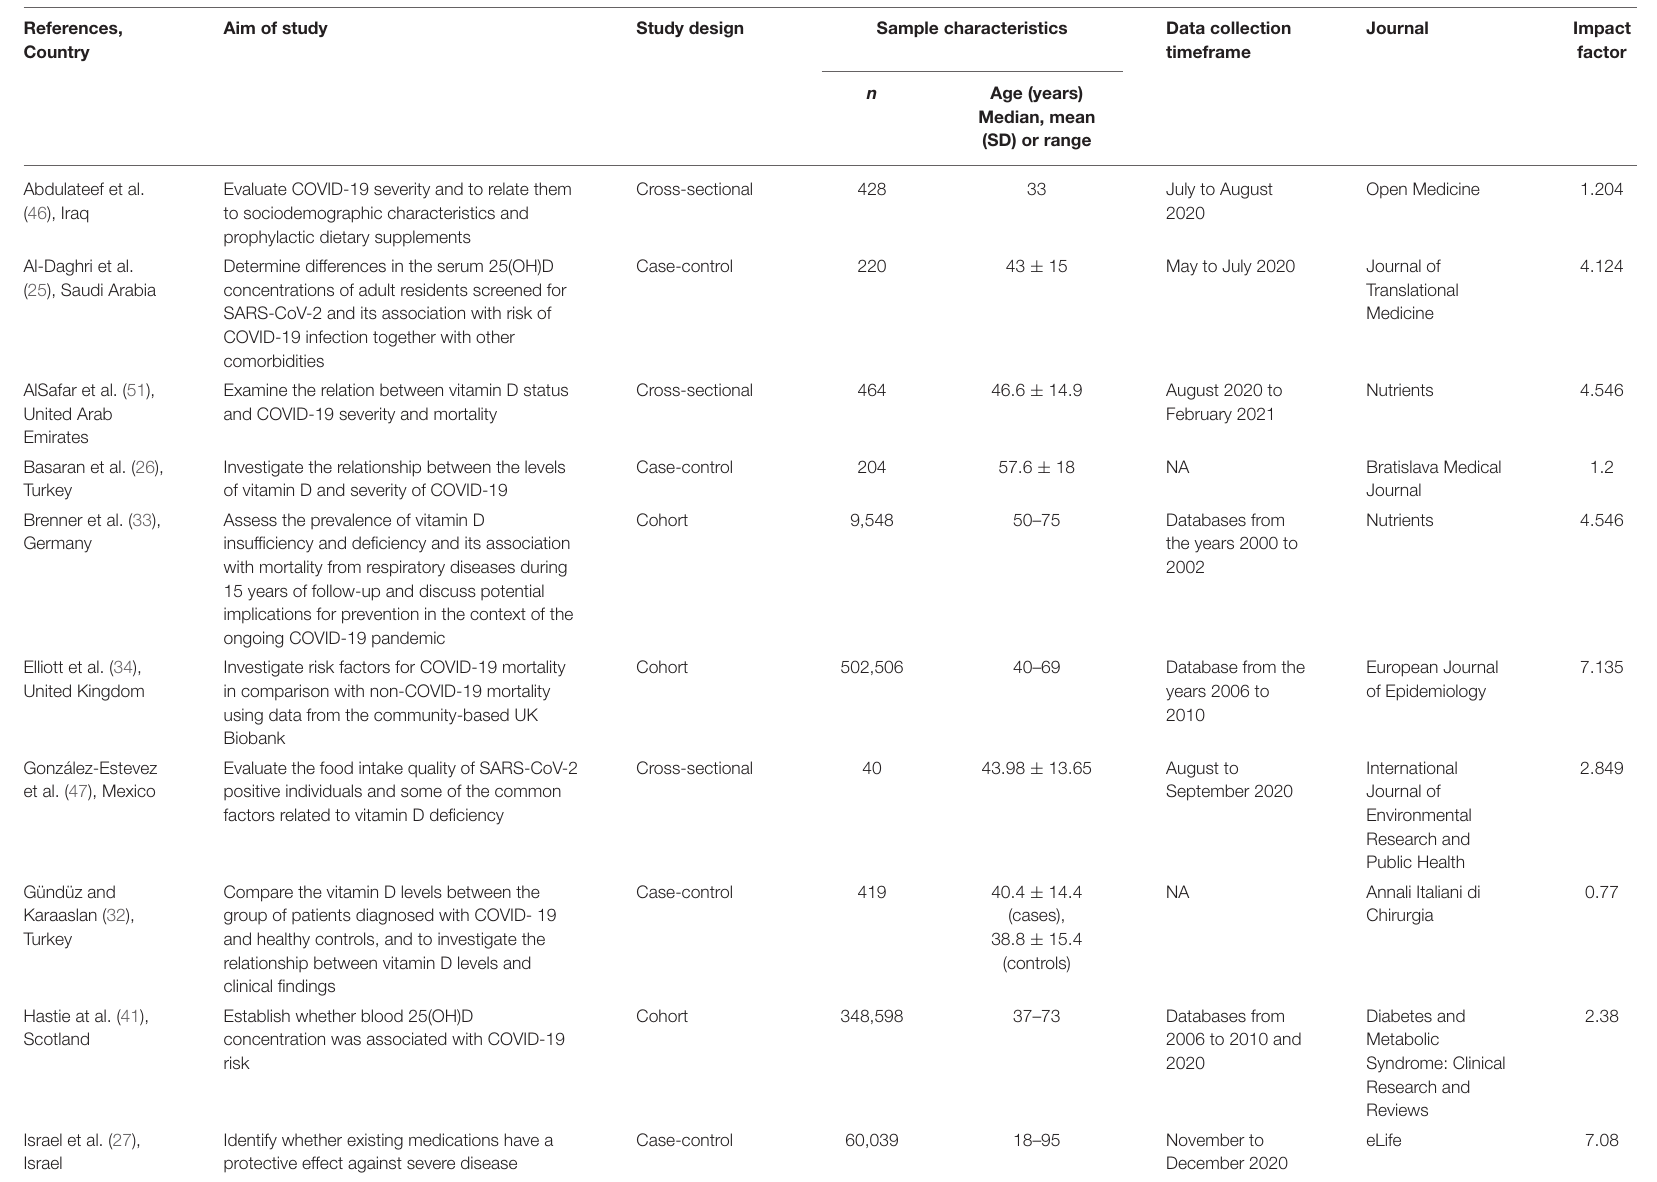
TABLE 1 | Study characteristics ( n =